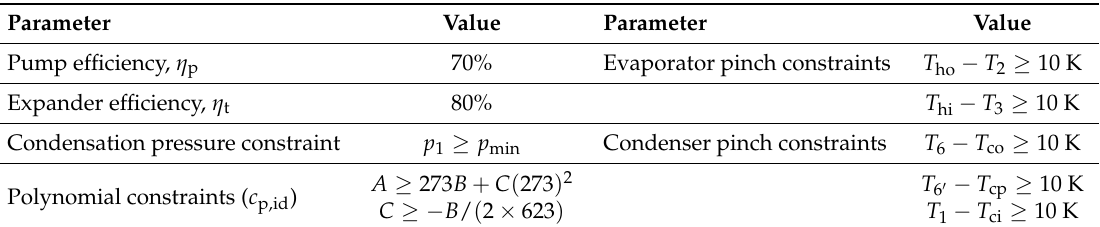
Table 3. Constraints and fixed parameters for the thermodynamic optimisation